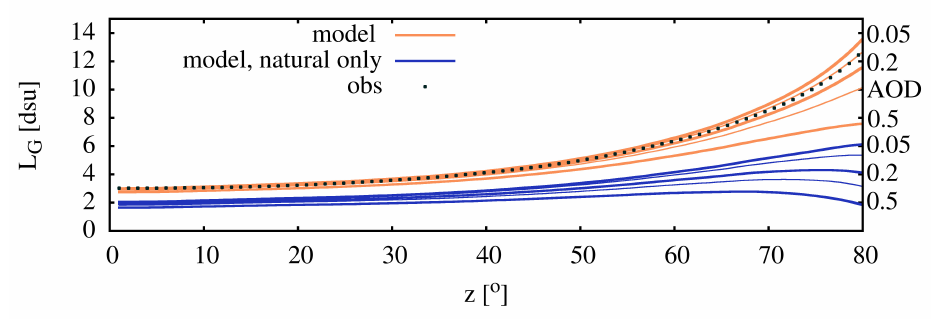
Figure 14. The mean radiance of the sky as the function of the zenith distance and AOD. The blue lines represent only the natural component (GAMBONS model). The AOD is indicated at the right side of the figure for the thick lines. The intermediate values for the thin lines are AOD = 0.1 and 0.3.